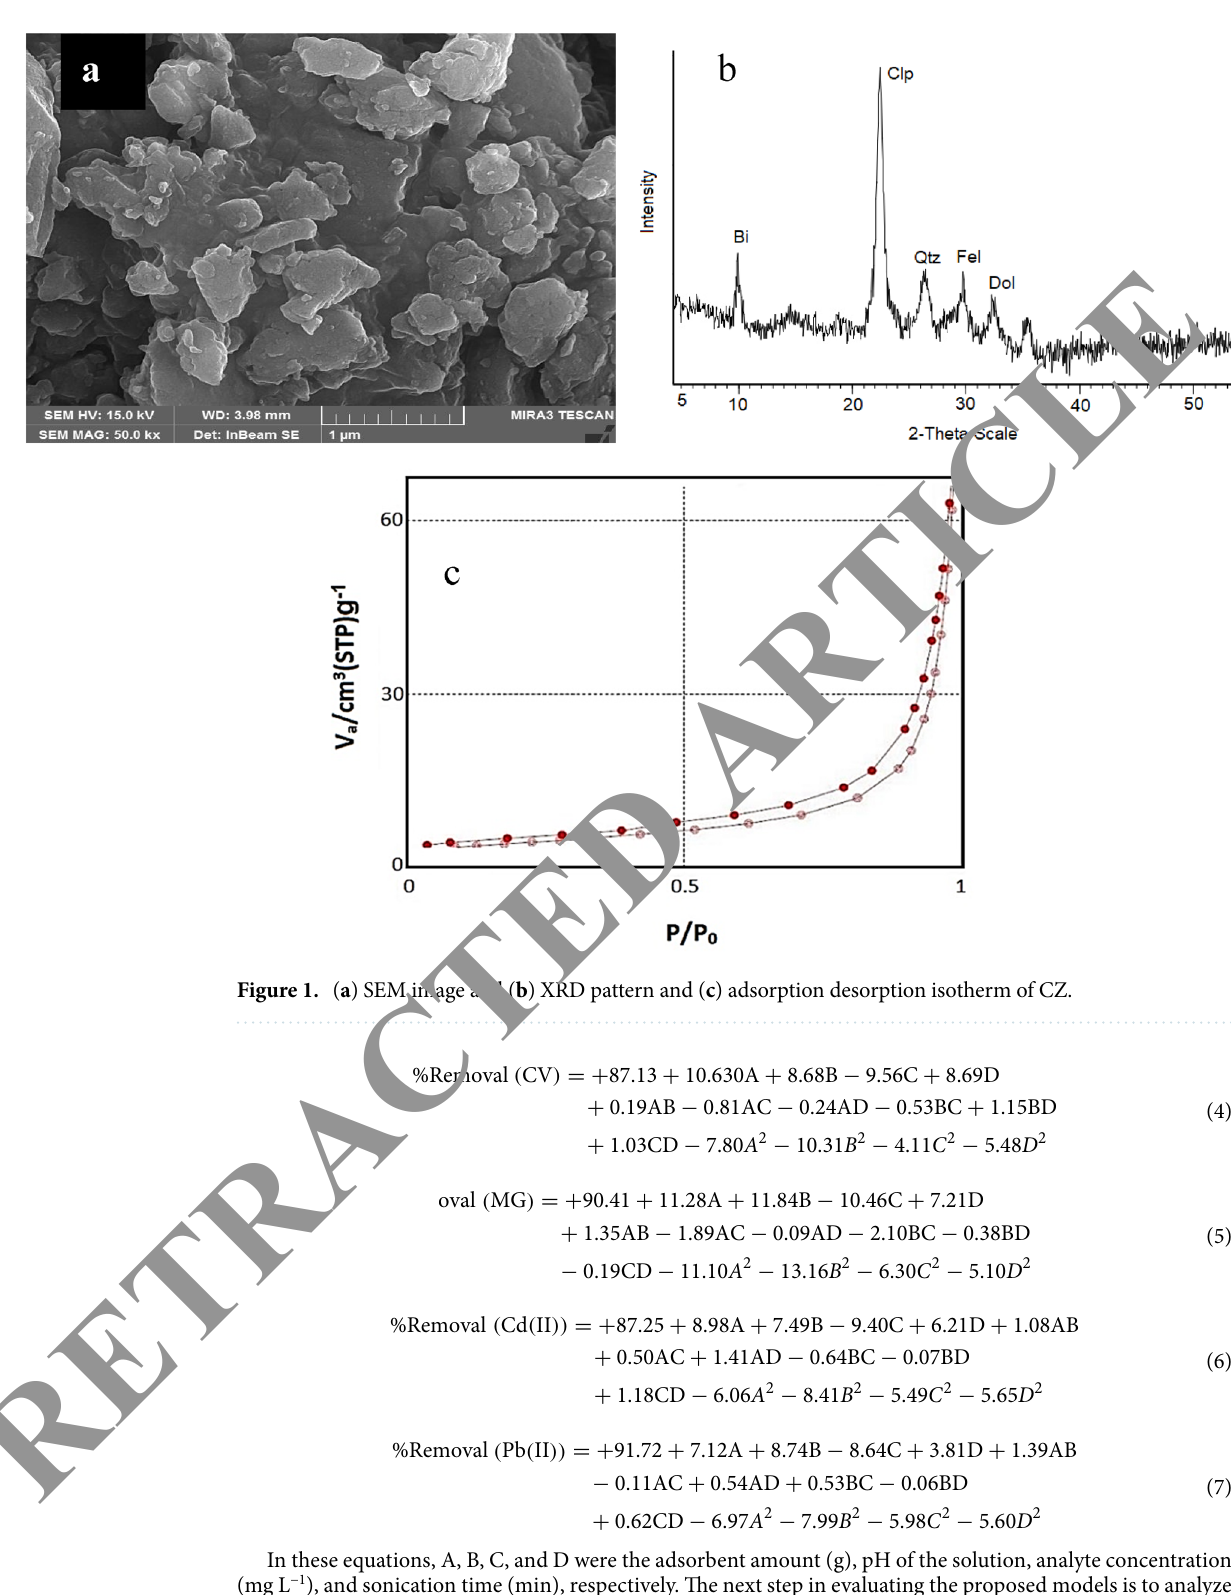
Figure 1. ( a ) SEM image and ( b ) XRD pattern and ( c ) adsorption desorption isotherm of